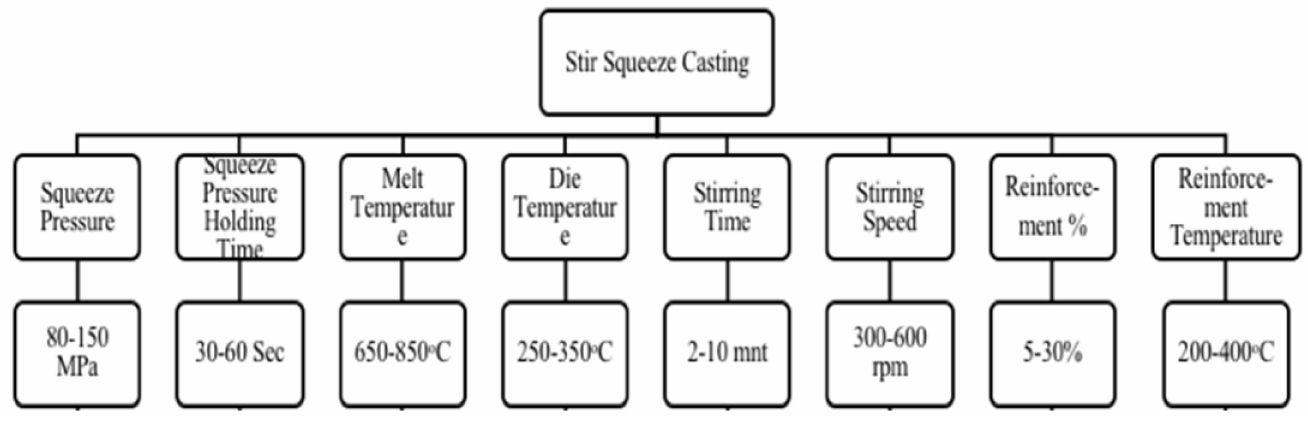
Figure 2. Important process parameters of stir squeeze casting